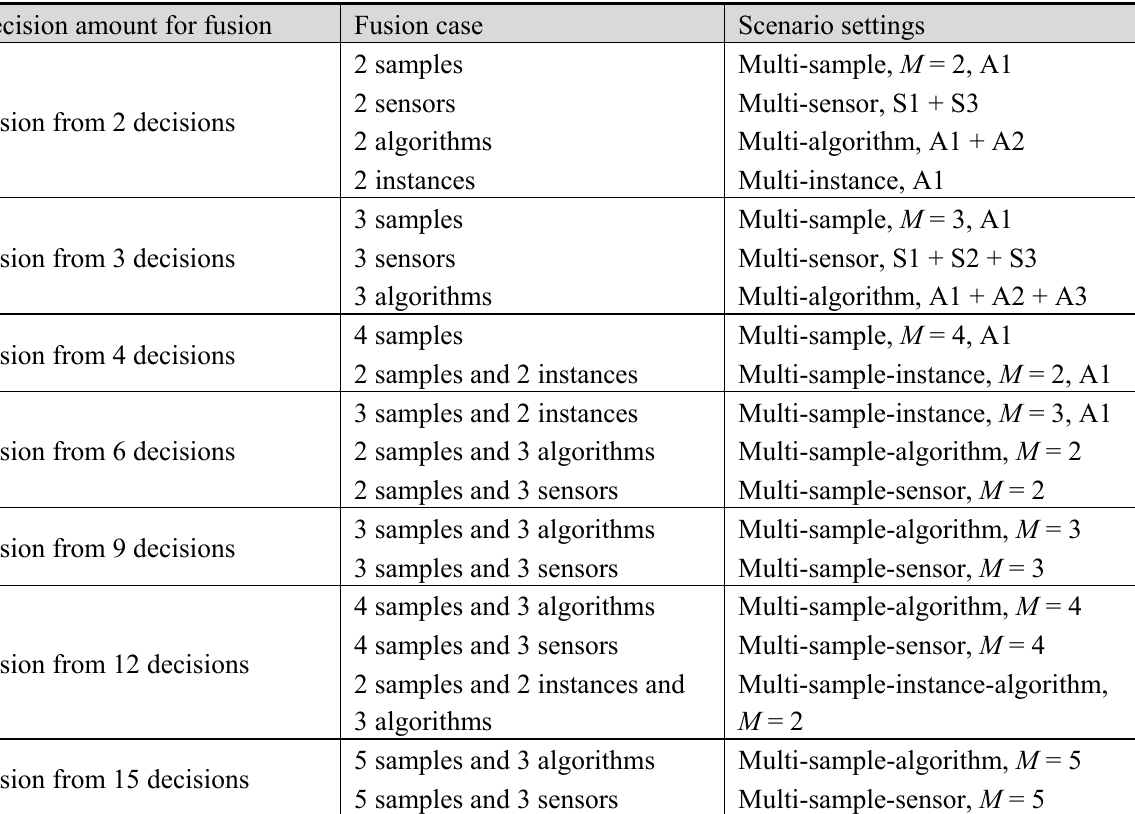
Table 11. Fusion scenario settings for fusion cases by “efficiency per